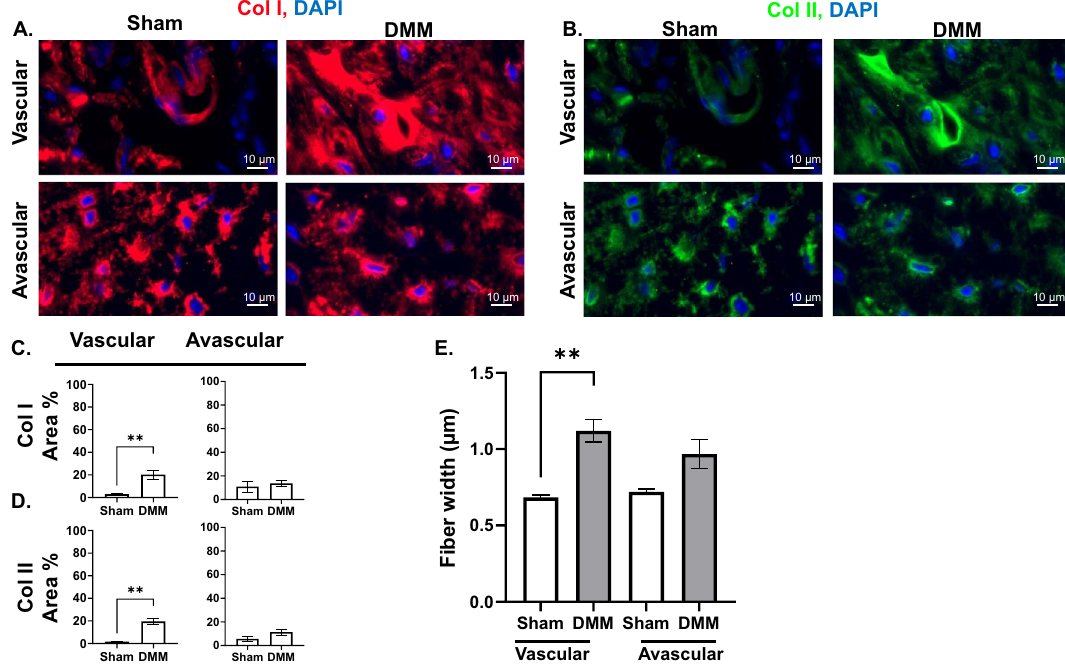
Figure 6. Collagen composition and fiber thickness in the posterior meniscus are affected by OA. IF staining for ( A ) Col I and ( B ) Col II expression in vascular (peripheral) and avascular (internal) regions of the posterior meniscus (× 40 magnification, scale bar = 20 μm, images acquired with Zeiss Zen Blue 2.6 edition software). Quantification of area percentage (area of positive signal normalized to total selected area) of ( C ) Col I and ( D ) Col II IF stains. ( E ) Comparison of FSHG fiber width (μm) between sham and DMM samples in each ROI. ** P < 0.01 using unpaired t-test with Welch’s correction, values are expressed as mean ± SEM; 3 images were analyzed per ROI in each sample, N =